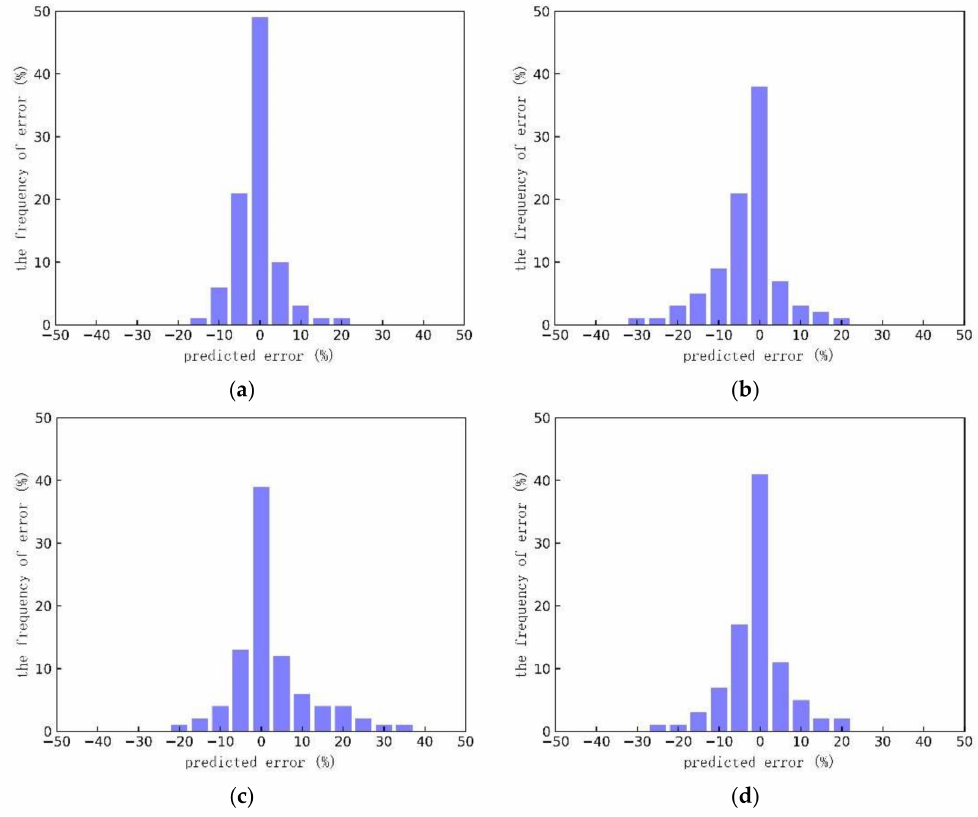
Figure 12. Error frequency distributions for different databases: ( a ) clustering database; ( b ) 13# sub-database; ( c ) 15# sub-database; ( d ) 26#